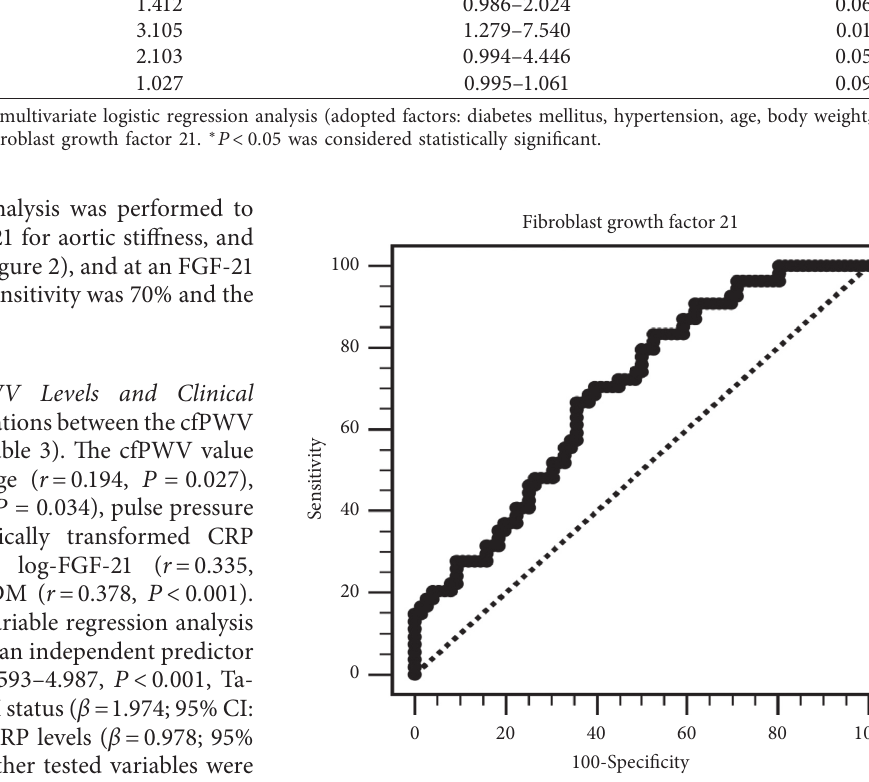
Figure 2: The area under the receiver operating characteristic curve indicates the predictive power of fibroblast growth factor 21 for aortic stiffness.